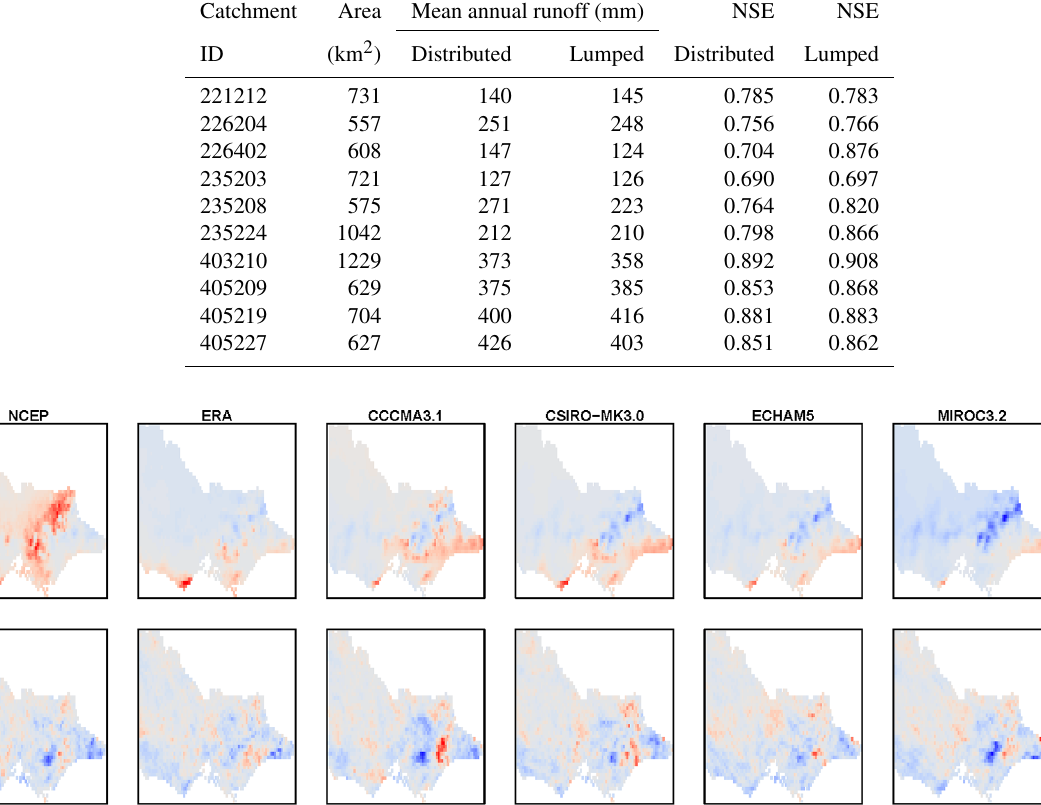
Figure 2. Historical (1990–2009) mean annual rainfall bias (WRF minus AWAP, mm) for (a) WRF-raw and (b) WRF-BC. Columns (left to right) are WRF runs forced by two reanalyses (NNR and ERAI) and then four GCMs (CCCMA3.1, CSIRO-MK3.0, ECHAM5 and